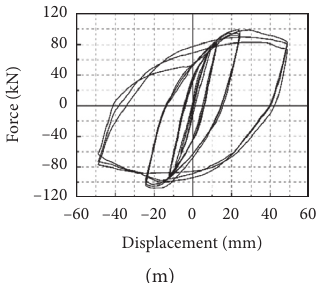
Figure 9: Horizontal force-displacement responses of the test specimens. (a) E1.0-c45-0.2. (b) E1.3-c45-0.2. (c) E1.8-c45-0.2. (d) E2.3-c45-0.2. (e) E1.8-c45-0.1. (f) E1.8-c45-0.3. (g) E1.8-c45-0.2b. (h) E1.8-c45-0.3b. (i) E1.8-c45-0.2m. (j) E1.8-c45-0.2l. (k) E1.8-c60-0.2. (l) E1.8-c75-0.2. (m)